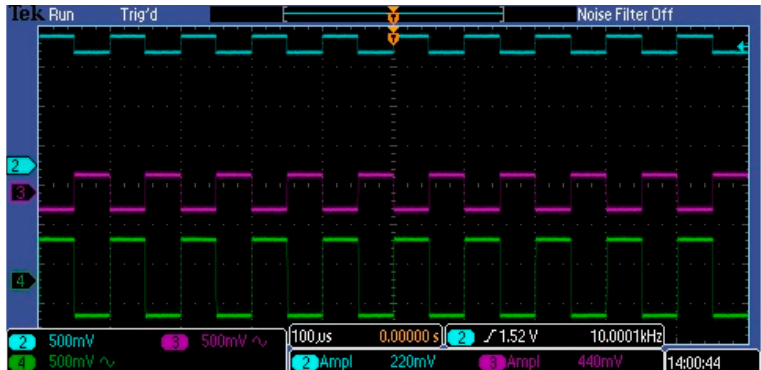
Figure 15. AC signal waveforms for the 10 kHz pulse frequency: blue waveform—input signal with high DC, purple—AC ingredient amplified twice, green—AC amplified four times.